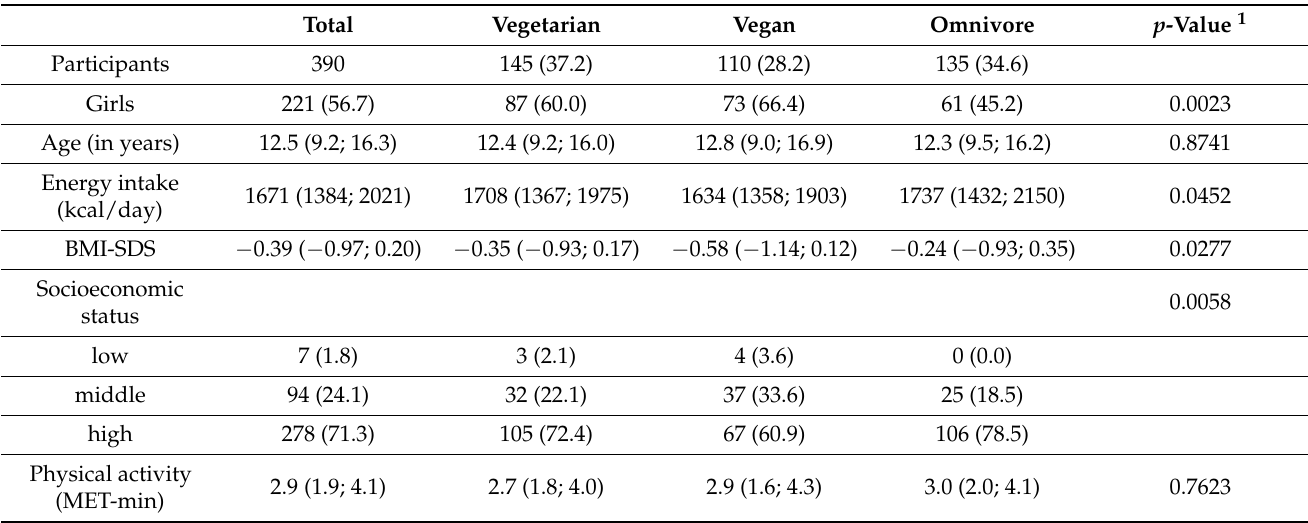
Table 2. Sample characteristics of VeChi Youth Study participants (n = 390) stratified by diet